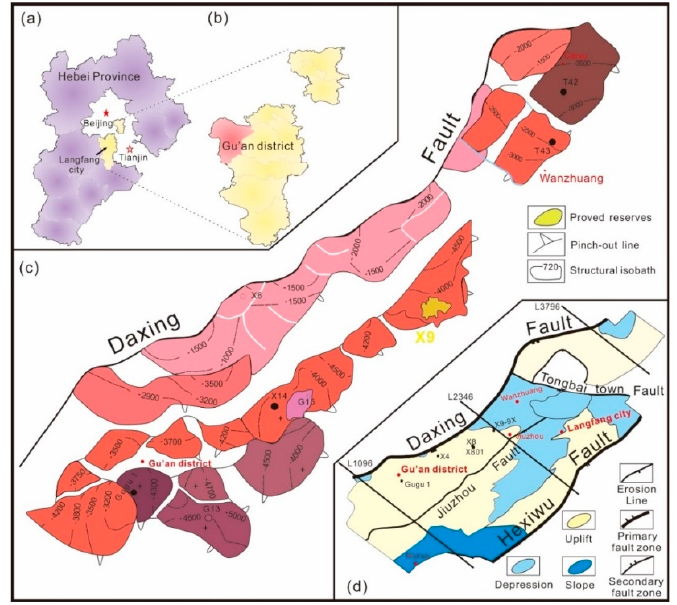
Figure 4. Tectonic geography of X9 conglomerate ( a ) Beijing–Tianjin–Hebei area; ( b ) Langfang city; ( c ) Distribution of Daxing conglomerate body; ( d ) Langgu sag.